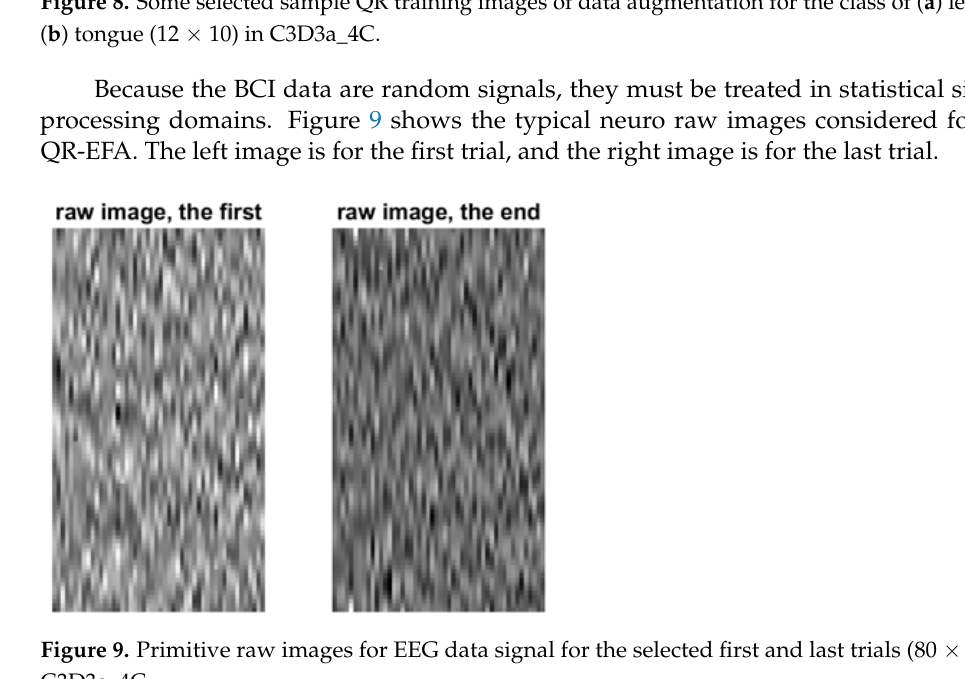
Figure 8. Some selected sample QR training images of data augmentation for the class of ( a ) left and ( b ) tongue (12 × 10) in C3D3a_4C.